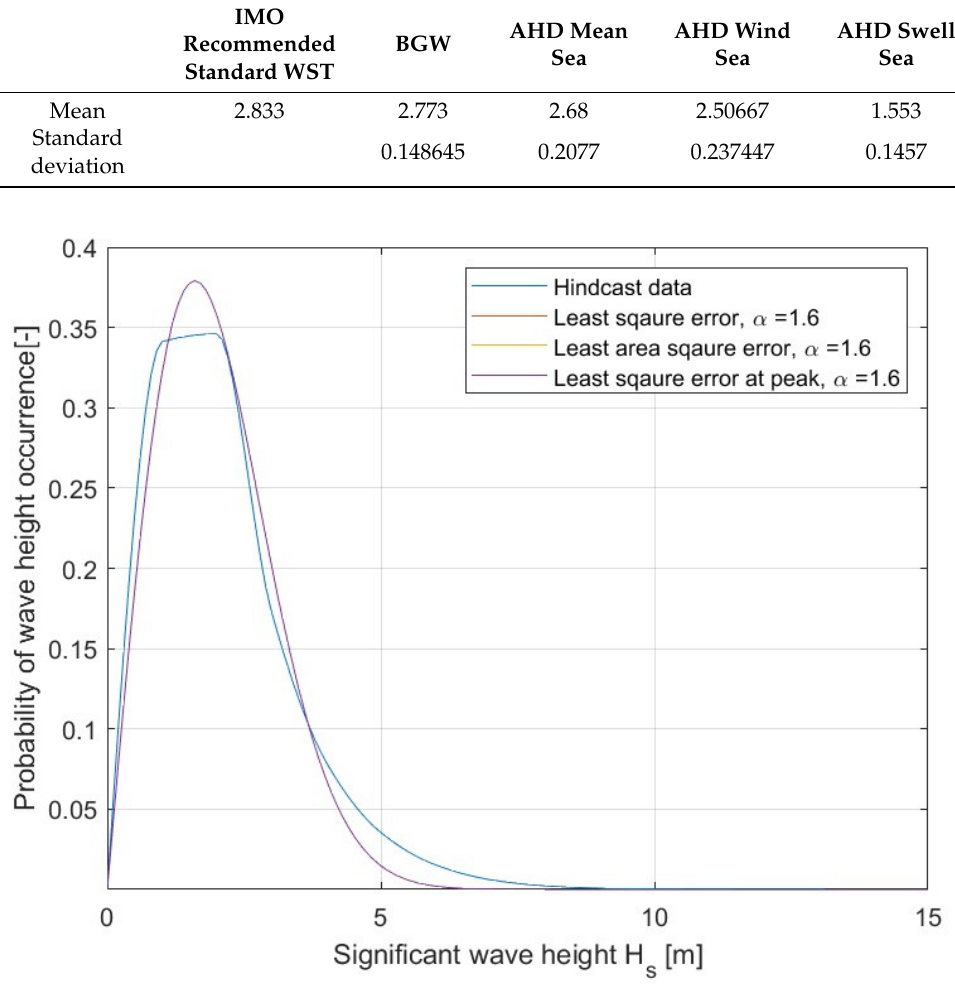
Table 5. Statistical comparison of Rayleigh shape parameter for mean, wind and swell sea pdf (sea area S—full year).